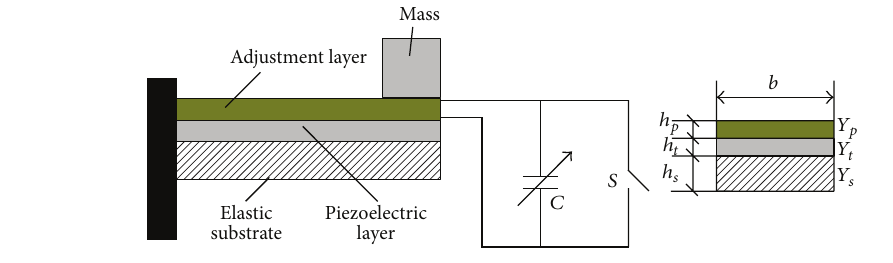
Figure 2: Capacitance FM principle.